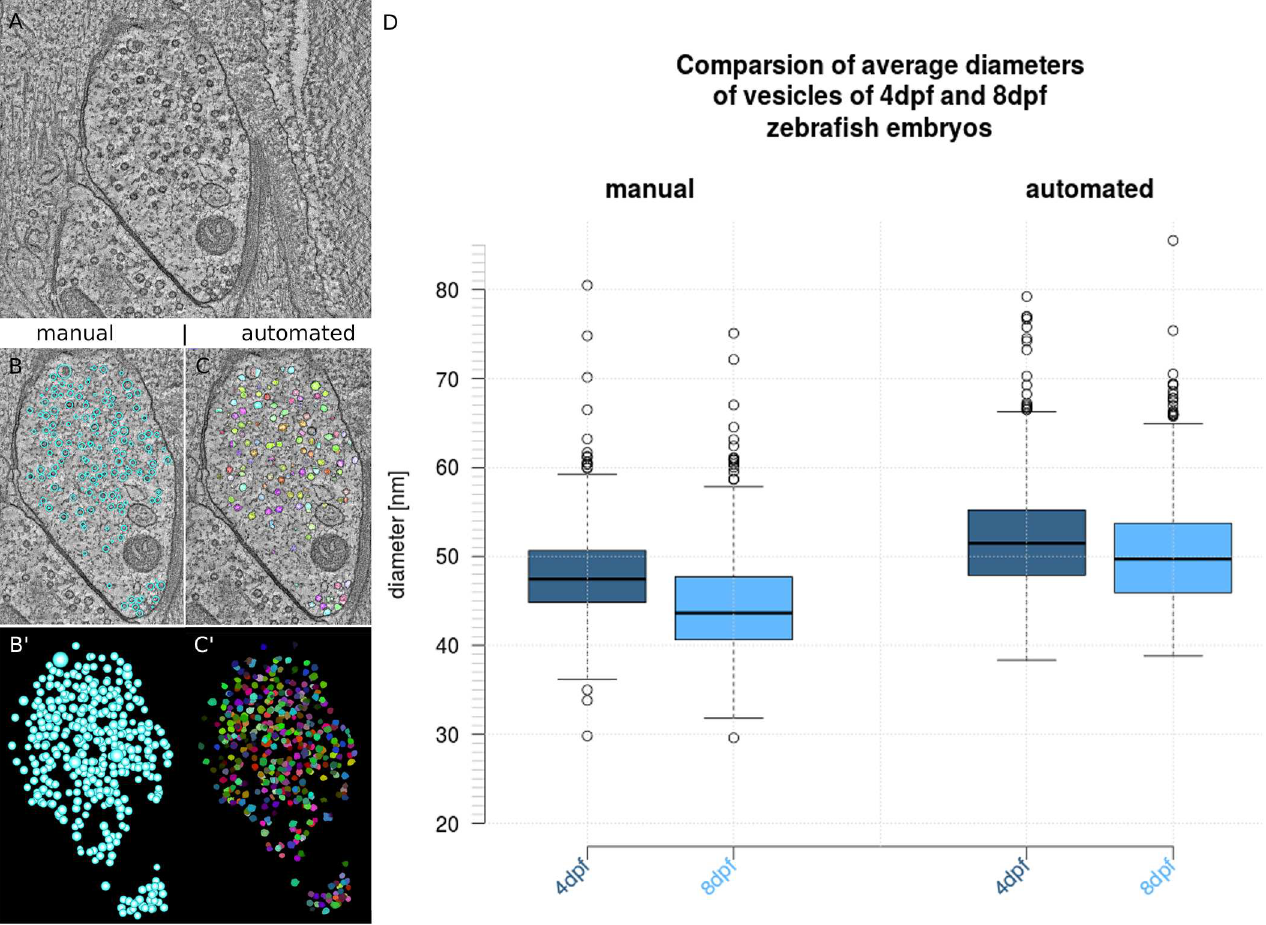
Fig 2. Analysis of embryonic zebrafish NMJ using 3D ART VeSElecT in comparison to manual analysis using IMOD. We show in Fig 2 A) the originaltomogram of 4dpf zebrafish NMJ, in Fig 2 B) the manualreconstruction is includedin the tomogram of A), in B’) the 3D reconstruction of the manualannotation (vesicles are colored in light blue) is shown. This is comparedto Fig 2 C) which shows the semi-automated vesicle recognition overlaidwith the originaltomogram, and C’) which shows the vesicle pool of the semi-automated annotationas 3D reconstruction (vesicles are in arbitrary colors). In D) boxplotsshow the results of the comparisonof 4dpf and 8dpf zebrafishembryos using manual annotation (left) and semi-automated annotation (right). The box of the box plots shows the mid-50% of data. The line in the box represents the median of all data. Whiskers end at lowest value within 1.5 interquartile range (IQR) of the lower quartileand at the highestvalue within 1.5 IQR of the upper quartile. Data that is not includedin betweenboth whiskers are plotted as outliers with a